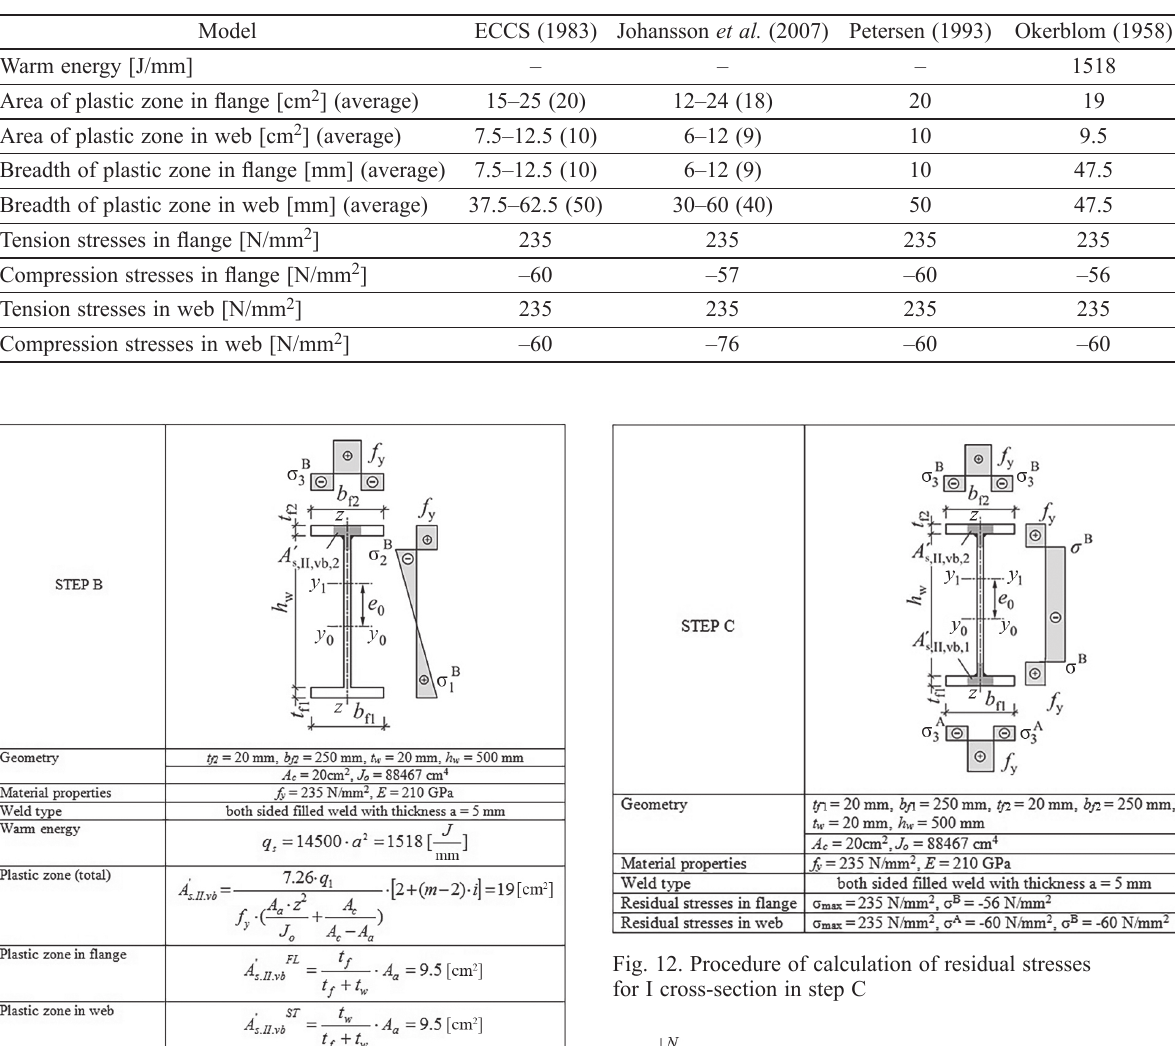
table 1. comparison of analytical and experimental models